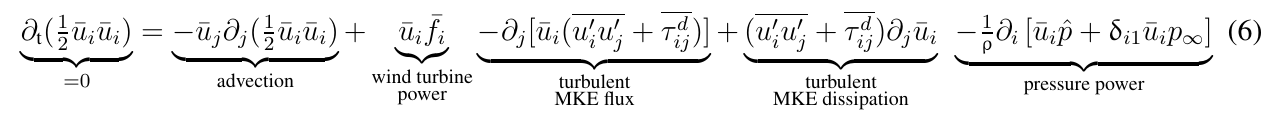
Figure 8. Contours of mean kinetic energy (MKE) ¯ E = 1 = 1 U 2 , are shown on three perpendicular planes ( x = L , y = L , energy at high altitudes E U 2 = D ) for the A = 0 baseline case. The turbine rotors are represented by small and z = z h grey ellipsoids that intersect the z = z h